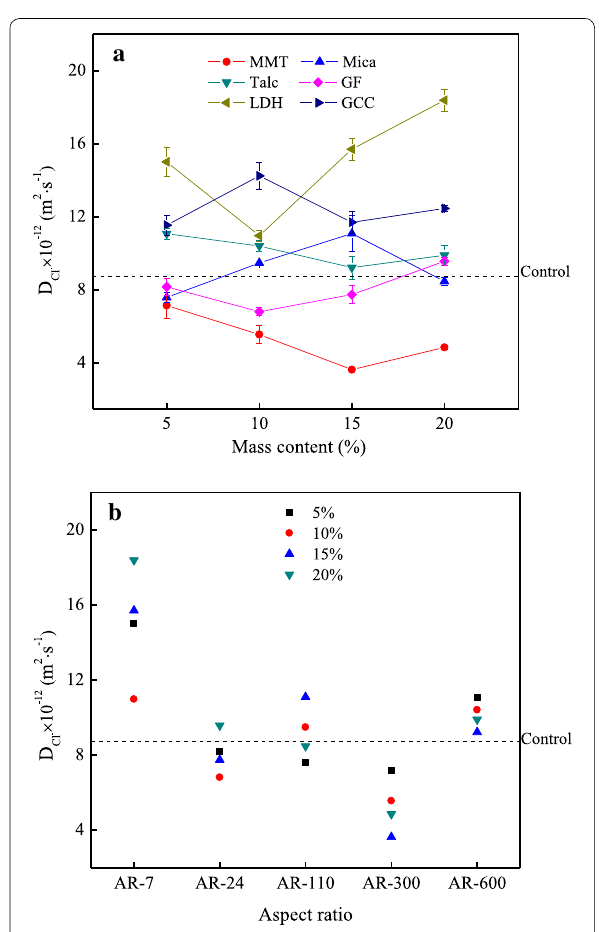
Fig. 5 Chloride diffusion coefficient of modified EECM with different fillers. a Filler contents; b aspect ratios of